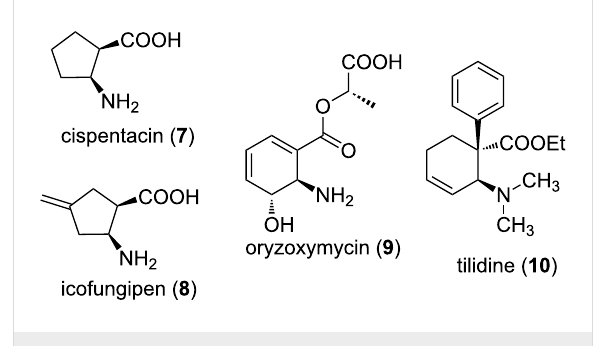
Figure 2: Selected bioactive alicyclic β -amino